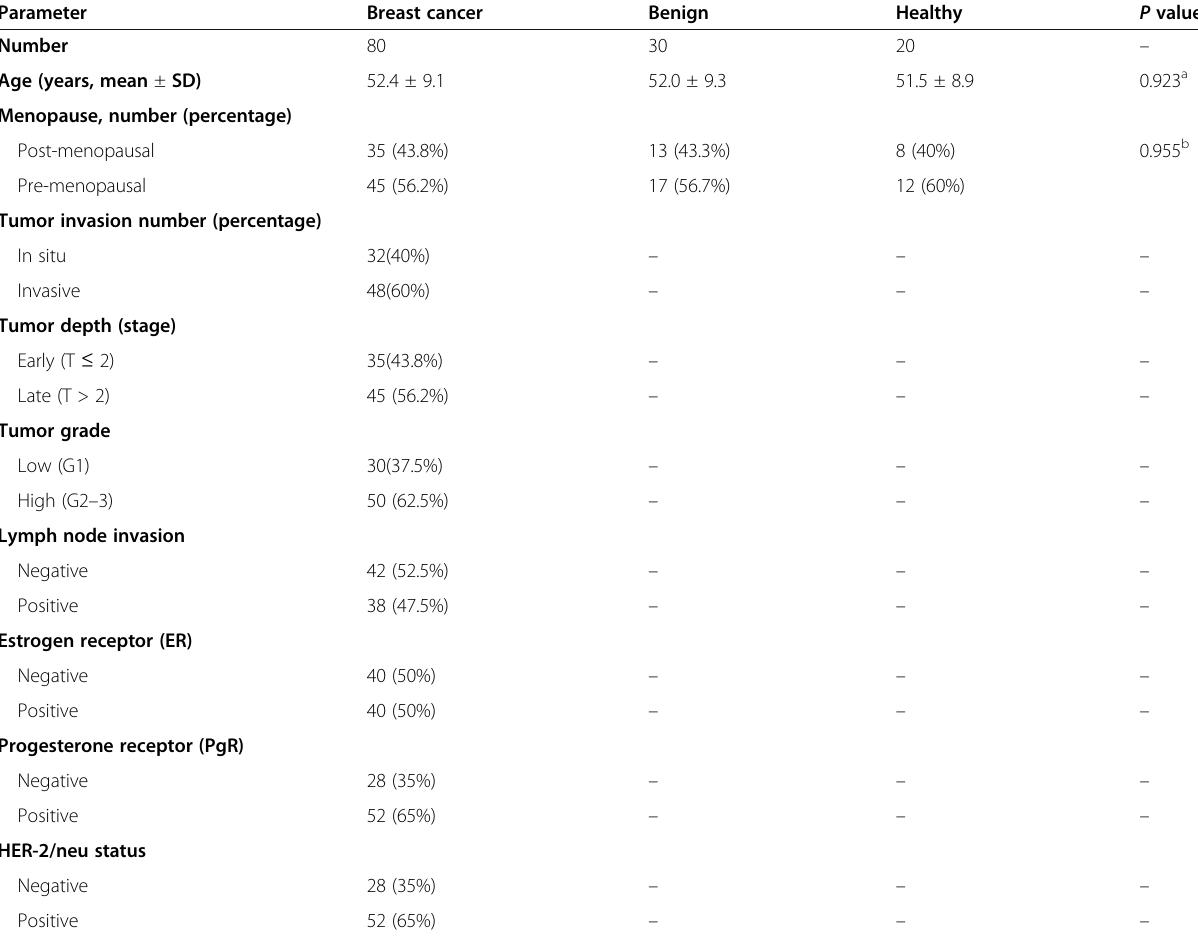
Table 1 Demographic and clinicopathological data of breast carcinoma patients